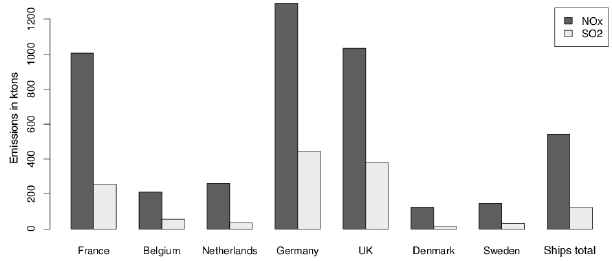
Figure 5. Total NO x and SO 2 emissions of ships in 2011 compared to some country